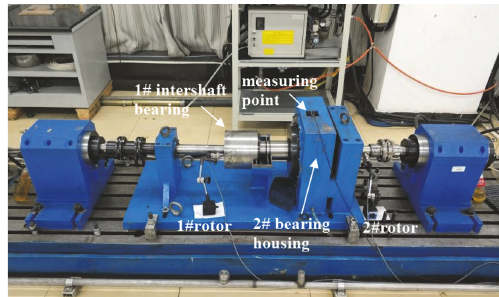
Figure 6: Test rig for dual-rotor faults